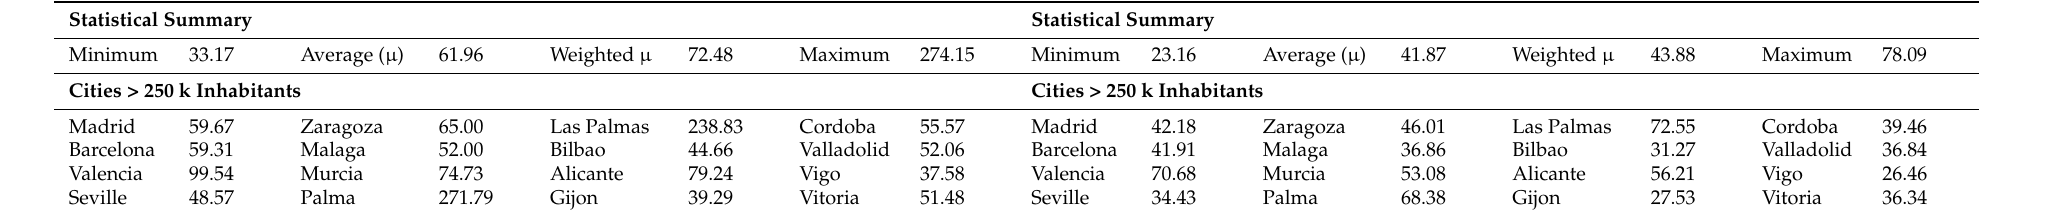
Figure 9. ST ERR in % (S3 (auxiliary electricity supply scenario) left , and S4 (auxiliary natural gas supply scenario) right ).